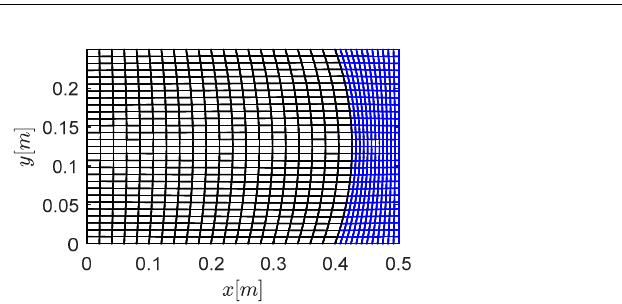
Figure 5. Grids investigated with curved interfaces: rectangular region divided by a curved interface.